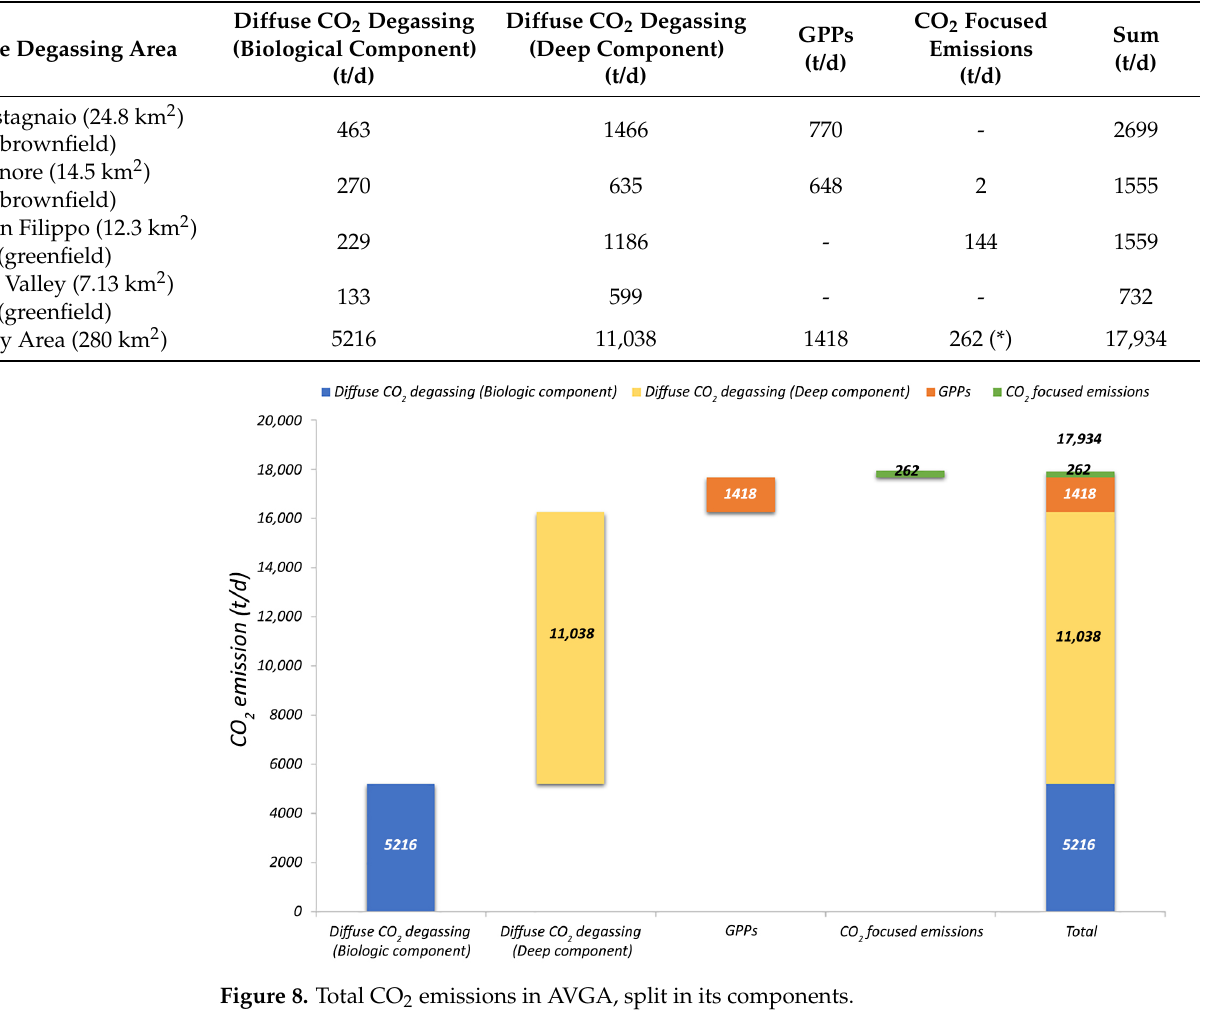
Table 7. CO 2 soil fluxes in different areas (brown and greenfields). GPPs data from [13]. (*) Sum of all CO 2 focused emissions in the Mt. Amiata volcanic–geothermal area (AVGA) area.